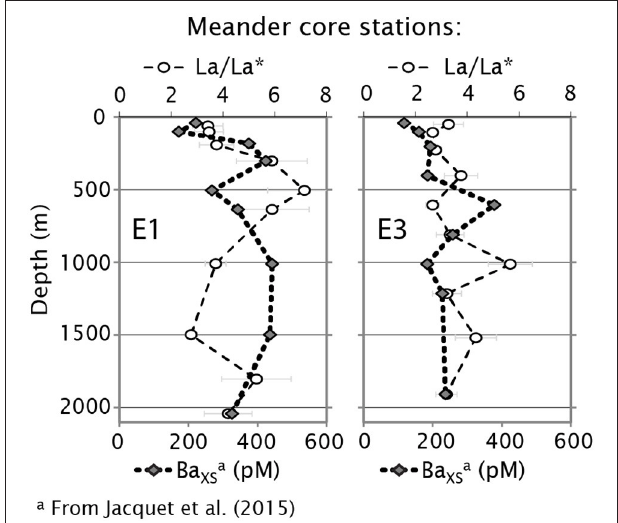
FIGURE 9 | Vertical profiles of La anomaly (La/La*) compared to the vertical profiles of particulate non-lithogenic barium concentrations (Ba XS , pM; from Jacquet et al., 2015) at the meander core stations E1 and E3. These plots highlight the mirroring of La/La* and Ba XS variations (local minima of La/La* associated with local maxima of Ba XS and vice